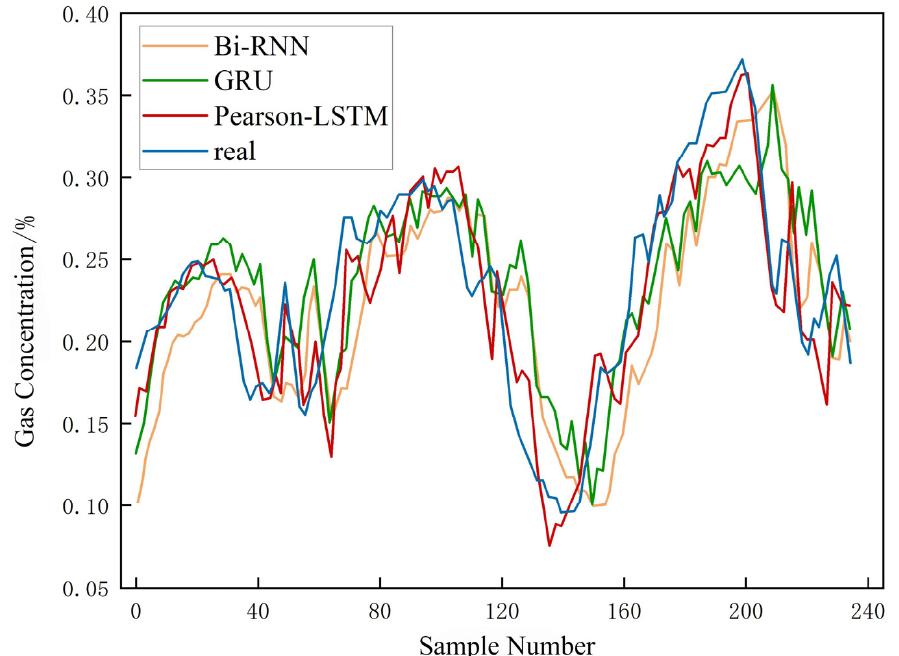
Figure 14. Comparison of the 15-minute prediction results of the three models.